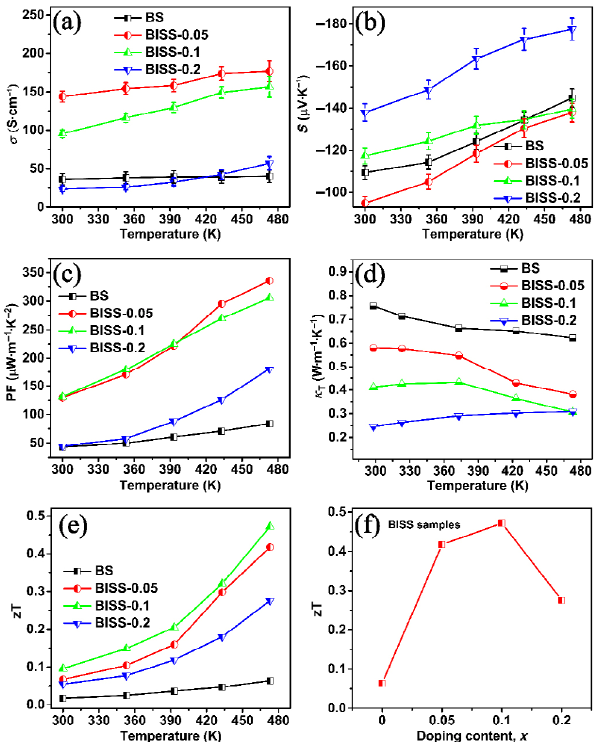
Figure 10 Temperature dependence of the (a) electrical conductivity, (b) Seebeck coefficient, (c) calculated power factor, (d) the total thermal, (e) the TE figure of merit dependence on temperature, (f) the maximum zT dependence on doping content at 473 K for all the BISS samples (where BS = Bi 2 Se 3 and BISS = Bi In Sb Se ; x = 0.05, 0.1, and 0.2). Adapted 2 3 3 x x x - with permission from Ref. [176], © American Chemical Society 2022. This leads to enhanced electronic properties via density of states optimization induced by the co-doping. It is worth mentioning that Bi (6p 3 ) substitution with In (5s 2 5p 1 ) is anticipated to restrict the scattering of conduction